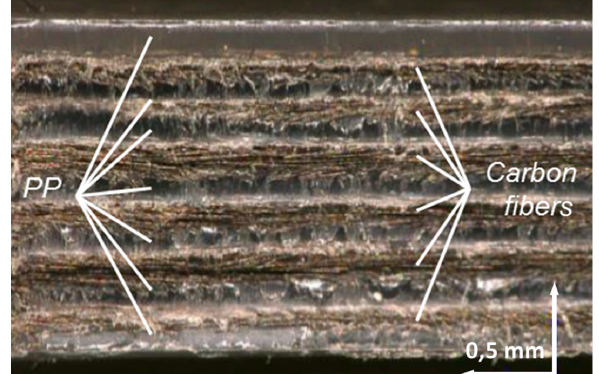
Figure 6. Microscopic view on a cut in direction of the fibers through a CFRP sample with a total thickness of approximately 1.8 mm made of six layers of carbon fibers and seven layers of PP-foils. In further experiments up to 17 layers of carbon fibers and 18 layers of PA film, all 100 µm in